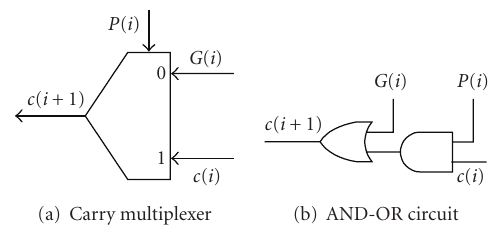
Figure 3: Carry-chain